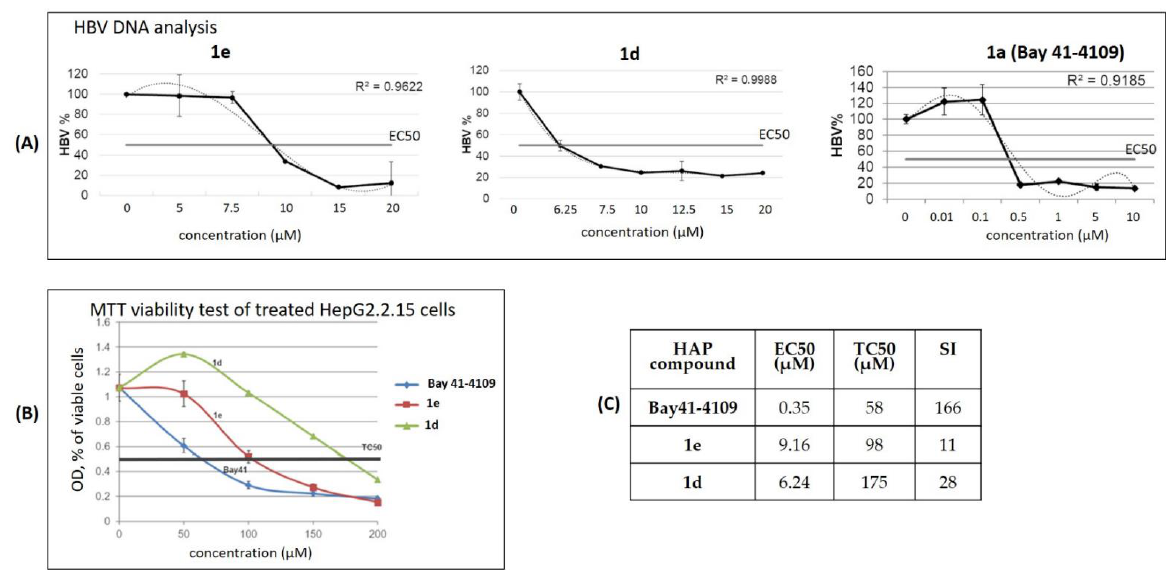
Figure 9. Antiviral activity and cell viability analysis of HAP comp. 1e and 1d in comparison with the reference comp. 1a (Bay 41-4109). ( A ) The HepG2.2.15 cells were cultured with the respective concentration of tested compound for six days. The HBV DNA was isolated from secreted virions from cell medium and quantified by the real-time PCR. Untreated cells were used as a control (100%); error bars represent the standard deviation of three repeats. ( B ) MTT-based viability test of HepG2.2.15 cells treated with respective compound for 48 h. Untreated cells were used as a control (100%); error bars represent the standard deviation of three repeats. ( C ) Calculated TC 50 and EC 50 concentrations and the corresponding selectivity indices SI (TC 50 /EC 50 relationship) of comp. 1a (Bay 41-4109) 1e , 1d .